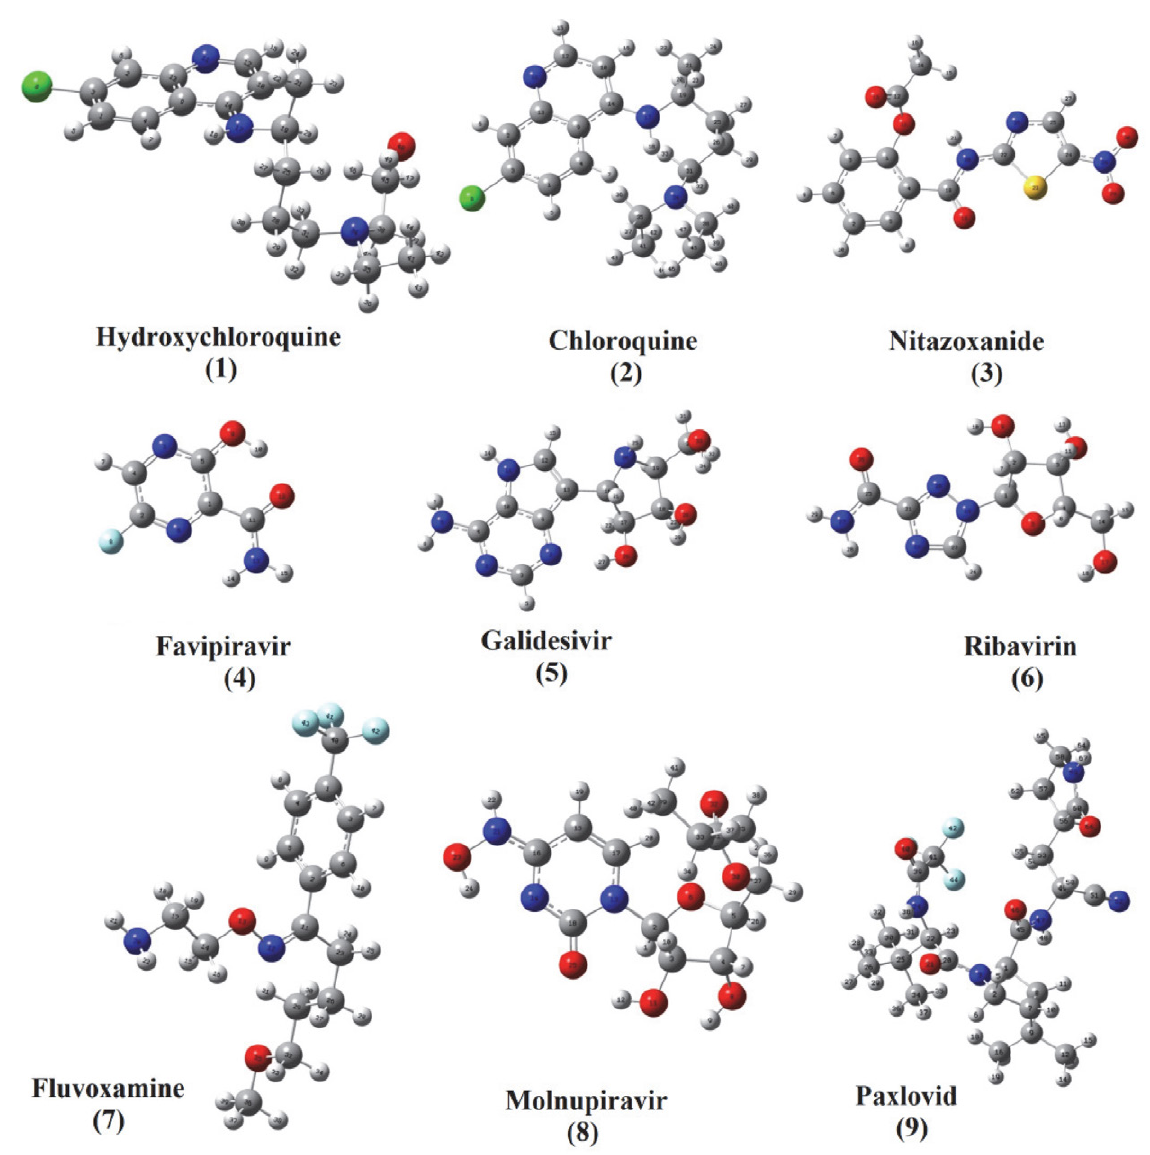
Figure 2. Optimized geometries of drug molecules